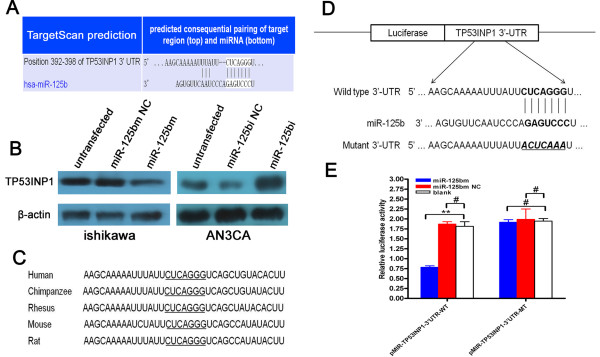
MiR-125b negatively regulated TP53INP1 protein levels in EC cells. A. Putative binding sites of miR-125b in the TP53INP1 3'UTR (white sequences) predicted by TargetScan. B. TP53INP1 protein levels were measured in EC cells at 72 h post-transfection by western blot assays. C. Potential binding site of miR-125b on TP53INP1 3'UTR in different species. The seed sequence is underlined. D. Sketch of the construction of pMIR-TP53INP1-3'UTR-WT or pMIR-TP53INP1-3'UTR-MT vectors. The mutant binding site is underlined and italicized. E. MiR-125bm down-regulated luciferase activities controlled by wild-type TP53INP1 3'UTR, but did not affect luciferase activity controlled by mutant TP53INP1 3'UTR (white sequences were mutated). The results are means of three independent experiments ± SD. (**P < 0.01 vs. blank; #P > 0.05 vs. blank).